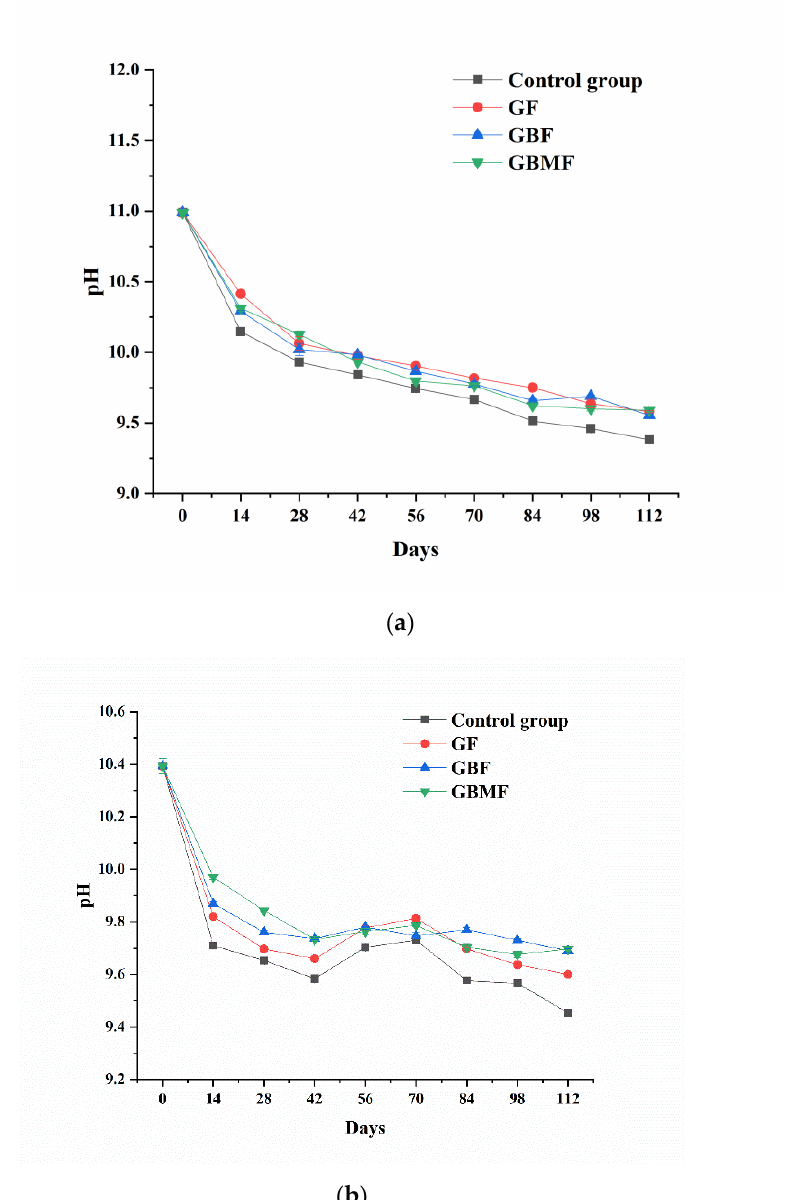
Figure 5. Changes of the pH of preserved egg white ( a ) and yolk ( b ) coated with different